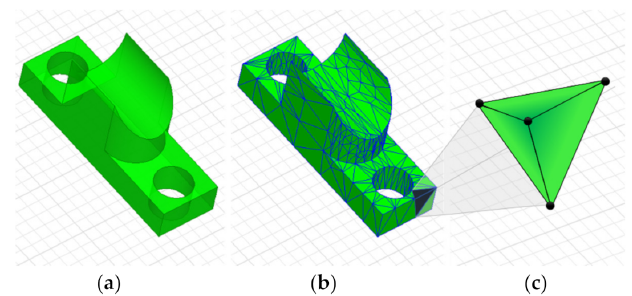
Figure 1. Basic definition of the FEM: ( a ) complex geometric problem ( b ) discretization of the problem, ( c ) simple geometry